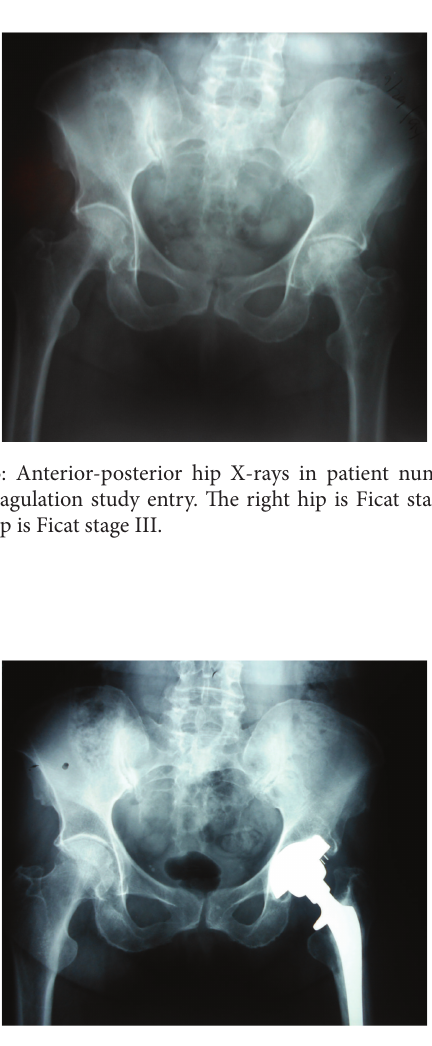
Figure 4: Anterior-posterior hip X-rays in patient number 4 after 5 years on Coumadin. The right hip is unchanged, Ficat stage II. The left hip, Ficat stage III at preanticoagulation study entry, was replaced before study entry.